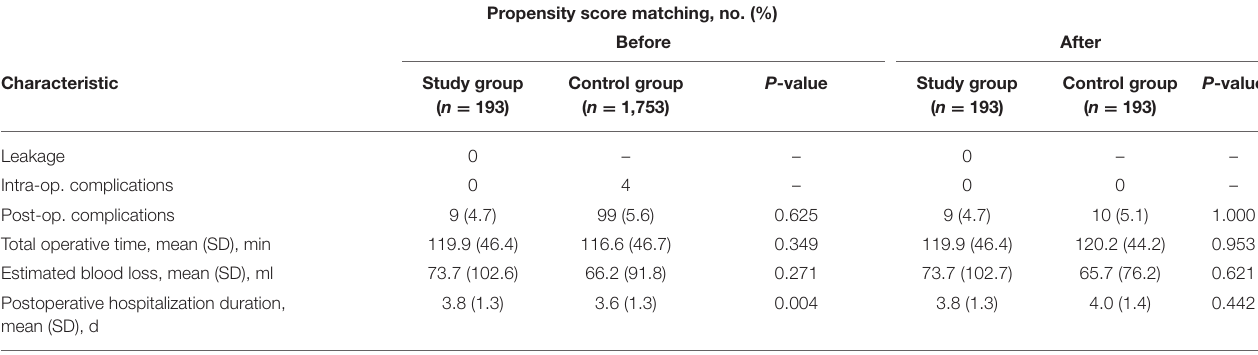
Propensity score matching, no. (%) Before After